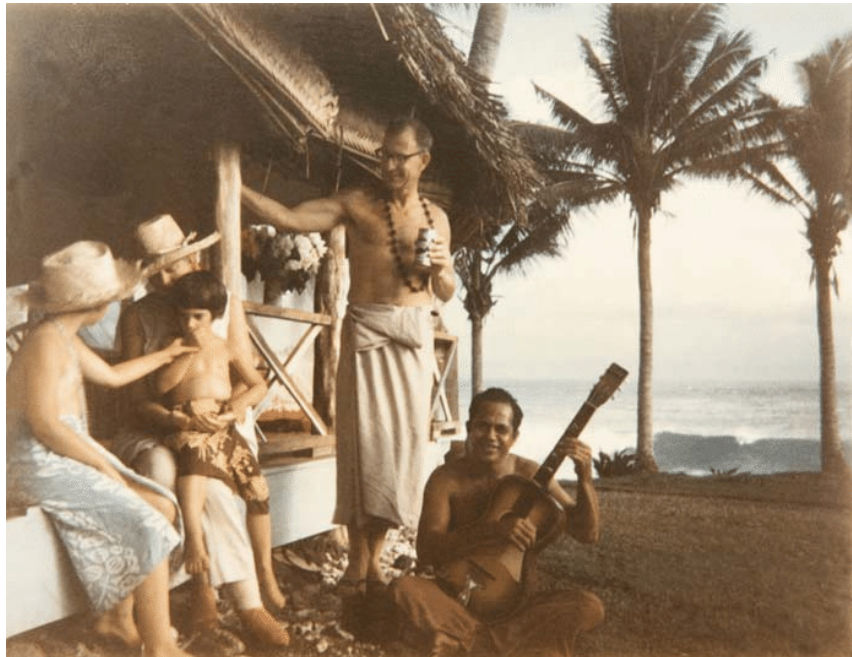
Figure 10: “Measuring ocean swell from a Fale in Tutuila, American Samoa (1963). Walter had persuaded Judith to take the 0400 daily watch of swell recording. (Edie, Kendall, Judith, Walter, and Silau playing the guitar).” From von Storch and Hasselmann 2010, figure 1.2, p.